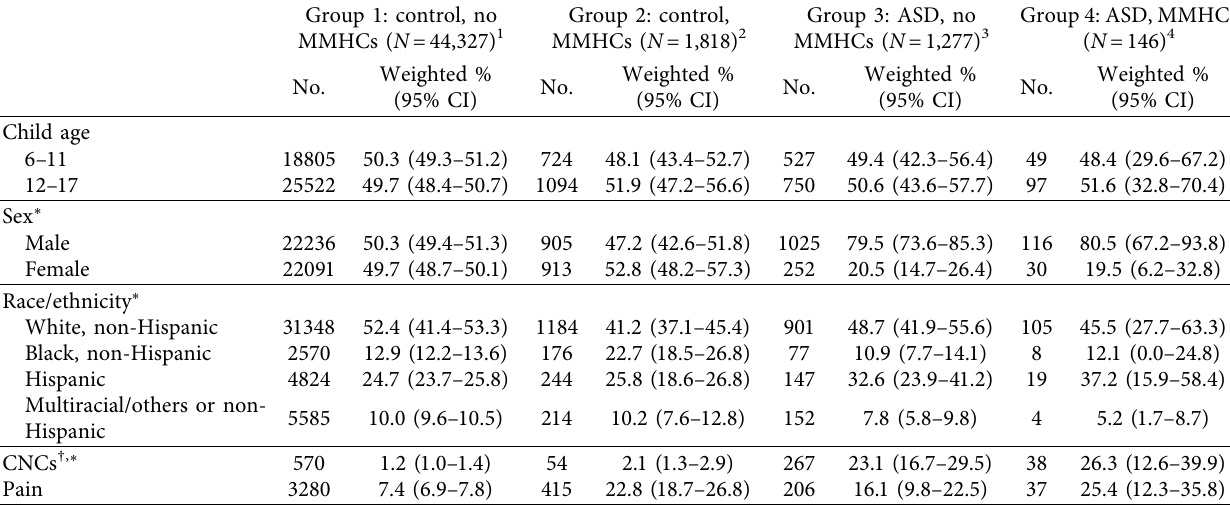
Table 1: Descriptive characteristics of individuals with and without ASD and maternal mental health conditions